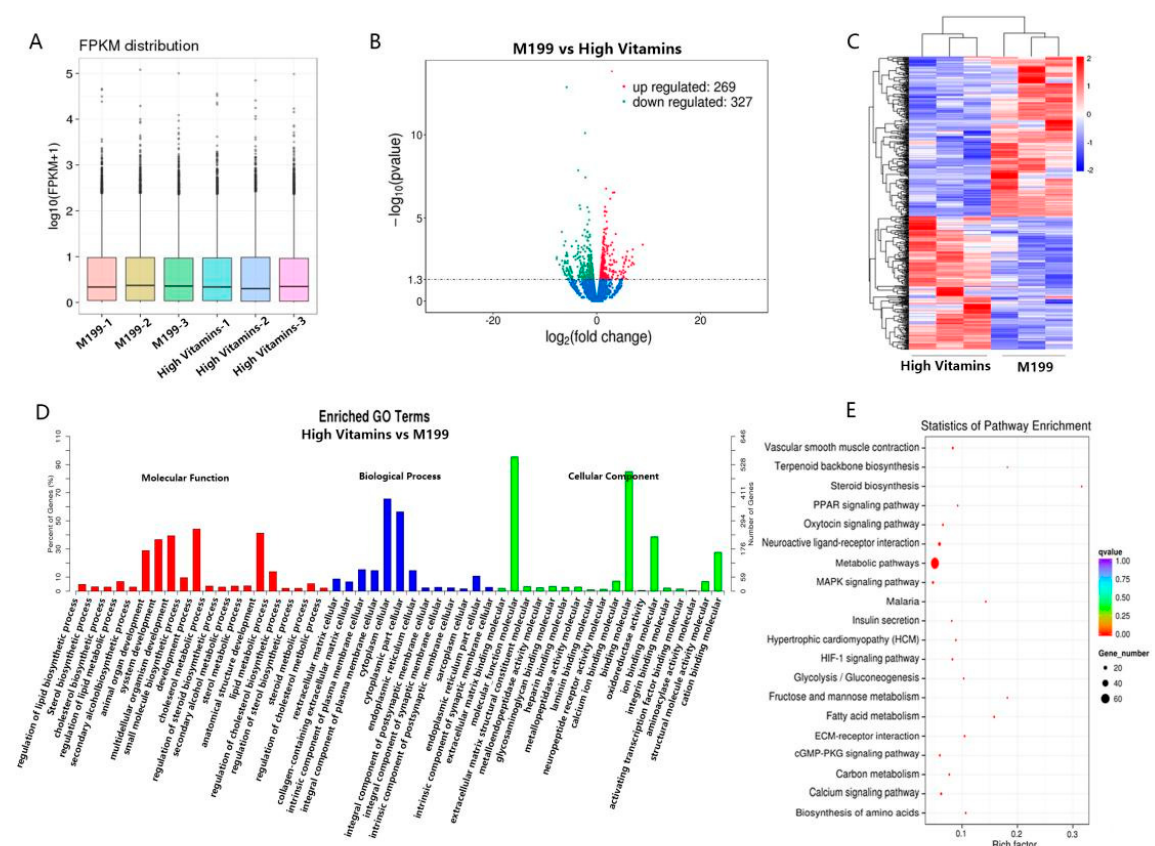
Figure 2. Transcriptomic analysis. ( A ) Box plot. Box plots of expression levels of different samples, where the abscissa is the sample name, and the ordinate is log10 (FPKM + 1). ( B ) The abscissa represents the fold change (log2 Fold Change) of gene expression between different samples or comparison combinations, the larger the absolute value of the abscissa, the greater the fold change of expression between the two comparison combinations; the ordinate represents the significance level of the expression difference. Up-regulated genes are indicated by red dots, down-regulated genes are indicated by green dots and blue dots are genes that did not change significantly. ( C ) The abscissa is the sample, the ordinate is the differential gene, the left side is the clustering of genes according to the similarity of expression, the upper is the clustering of each sample according to the similarity of the expression profile, the expression level is gradually increased from blue to red and the numbers are uniform the relative expression level after transformation. ( D ) The abscissa represents the name of GO items, which are divided into three categories by boxes, BP biological process, CC cell components and MF molecular functions, which are distinguished by different bars and boxes and the ordinate is the number of genes enriched by GO items. ( E ) The vertical axis in the figure represents different pathways, and the horizontal axis represents the proportion of significantly differentially expressed genes in the corresponding pathway to all genes in the pathway. The size of the circle represents the number of genes enriched in the corresponding pathway, and the larger the circle, the more genes are enriched in the pathway. The color represents the significance of enrichment, and the closer to red, the more significant it is.